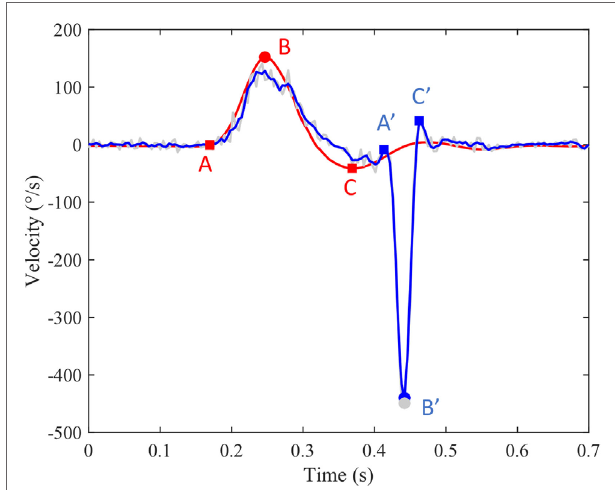
FigUre 1 | an example of filtered head velocity superimposed with filtered eye velocity and non-filtered eye velocity . Red curve: head velocity; blue curve: eye velocity; blue circle: peak saccade velocity; red circle: peak head velocity; gray circles: non-filtered peak saccade